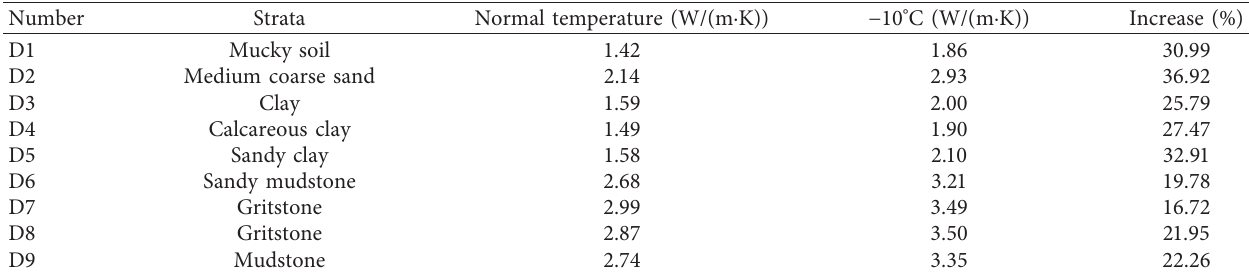
Table 3: Change in thermal conductivity of different rock and soil strata at normal and low temperatures.